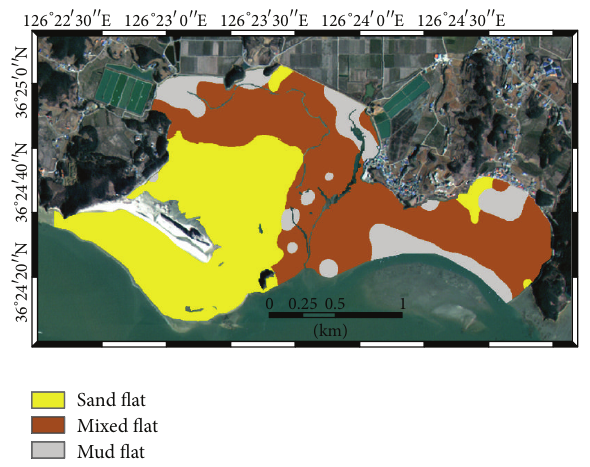
Figure 4: Surface sediment facies distribution generated by indica- tor kriging.